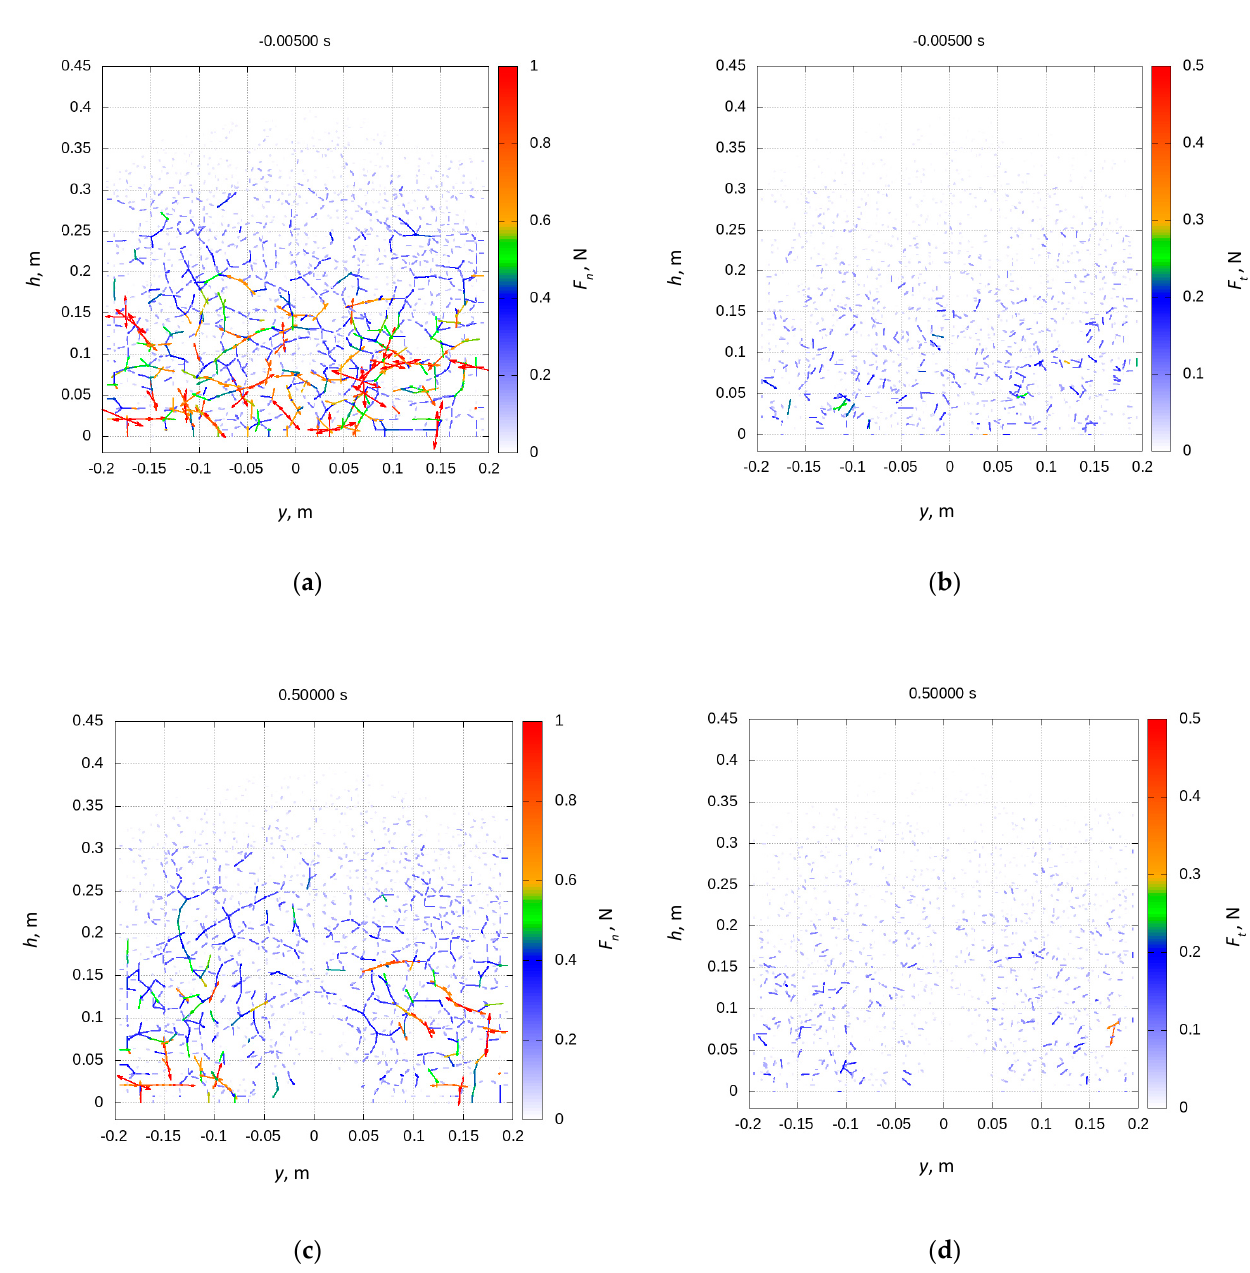
Figure 8. Network of interparticle normal (left column) and tangential (right column) forces at the cross-section of the bedding with D 0 = 0.055 m at static conditions ( a , b ) and at flow arrest ( c , d ). In contrast to the case with D 0 = 0.056 m, where no flow arrest occurred, an arch structure of stronger forces at a height equal to about two times the height of the dome was formed above the center of the floor during the discharge process (Figure 9a). This arch was later broken (Figure 9b), and an undisturbed mass flow phase was observed (compare with velocity profiles in Figure 5b,c).